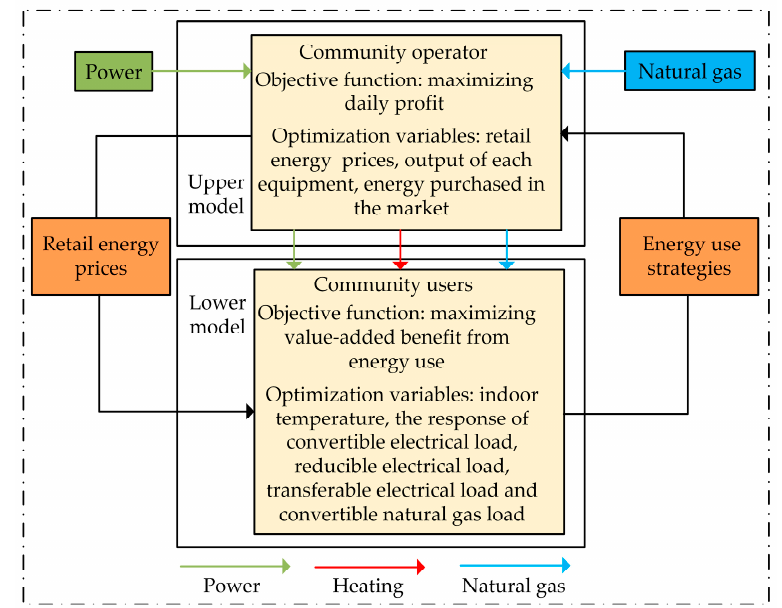
Figure 2. Multi-energy transaction decision-making model architecture between the community operator and the users.